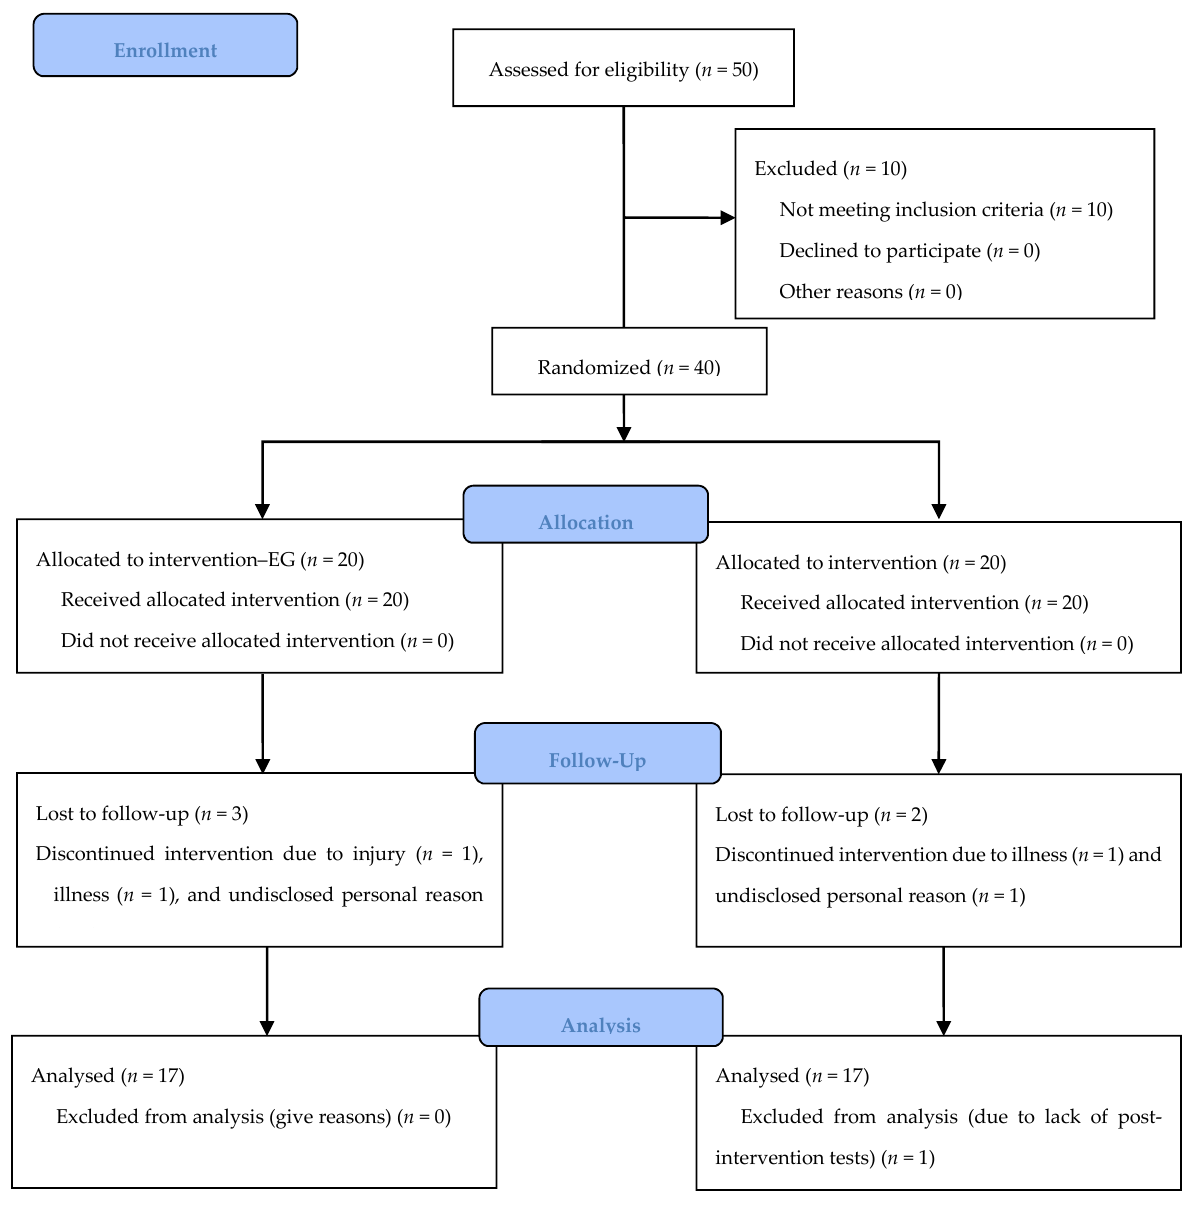
Figure 4. Flowchart of the experiment participants. Basic characteristics of both groups are presented in Table 1.